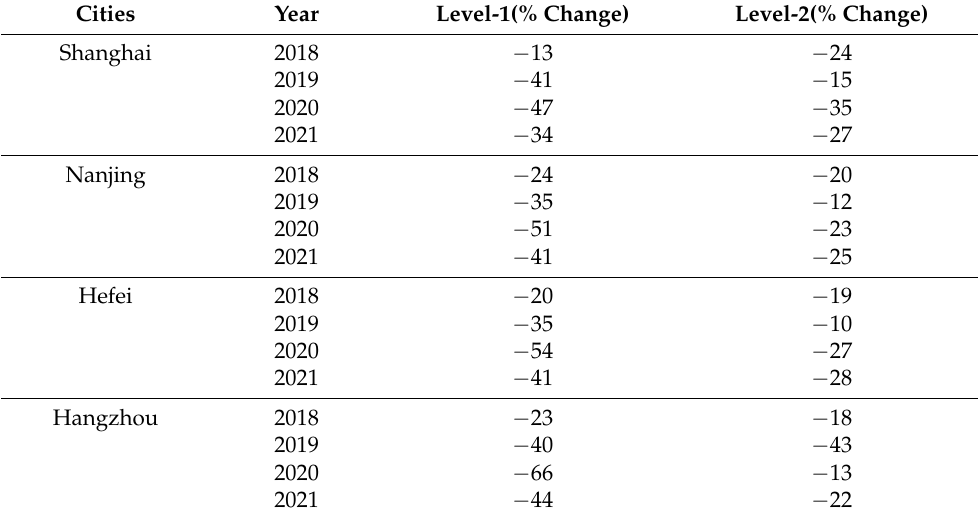
Table 2. Percentage change in mean NO 2 during lockdown levels (Level-1 (24 January–26 February) and Level-2 (27 February–31 March)) with reference to Pre-lockdown Phase (1 January–23 January).